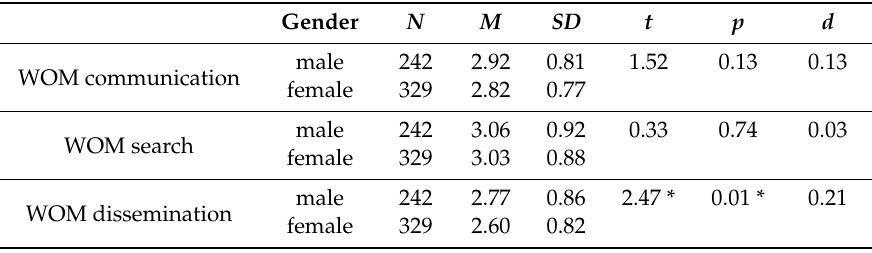
Table 2. t test for word of mouth (WOM) communication by gender.